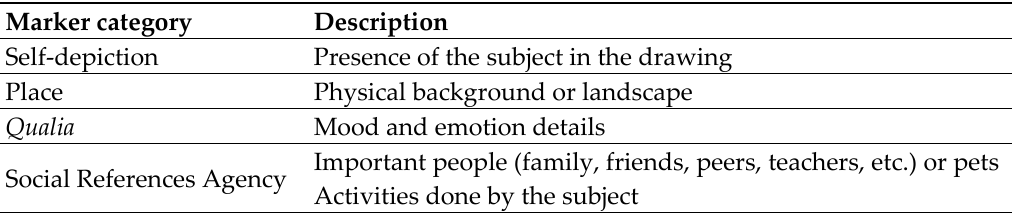
Table 1. List of markers used in our study.